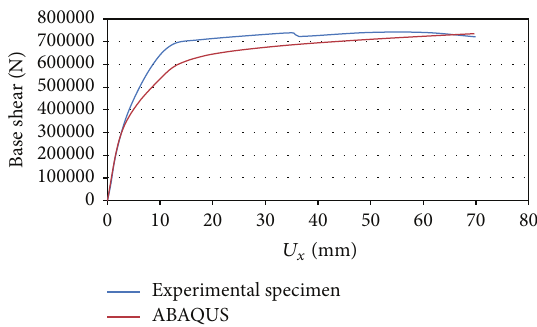
Figure 2: Load-displacement pushover curves of SPSWs specimens, from FEM analysis.